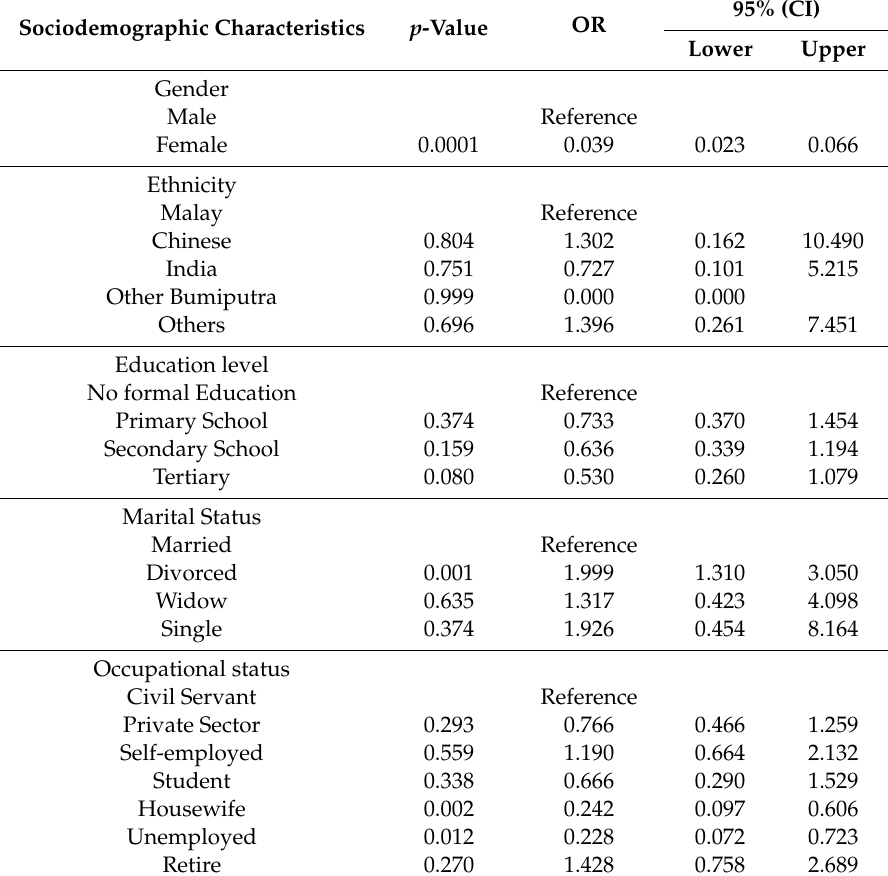
Table 3. Results of stepwise multivariate logistic regression between sociodemographic characteristics and smoking.